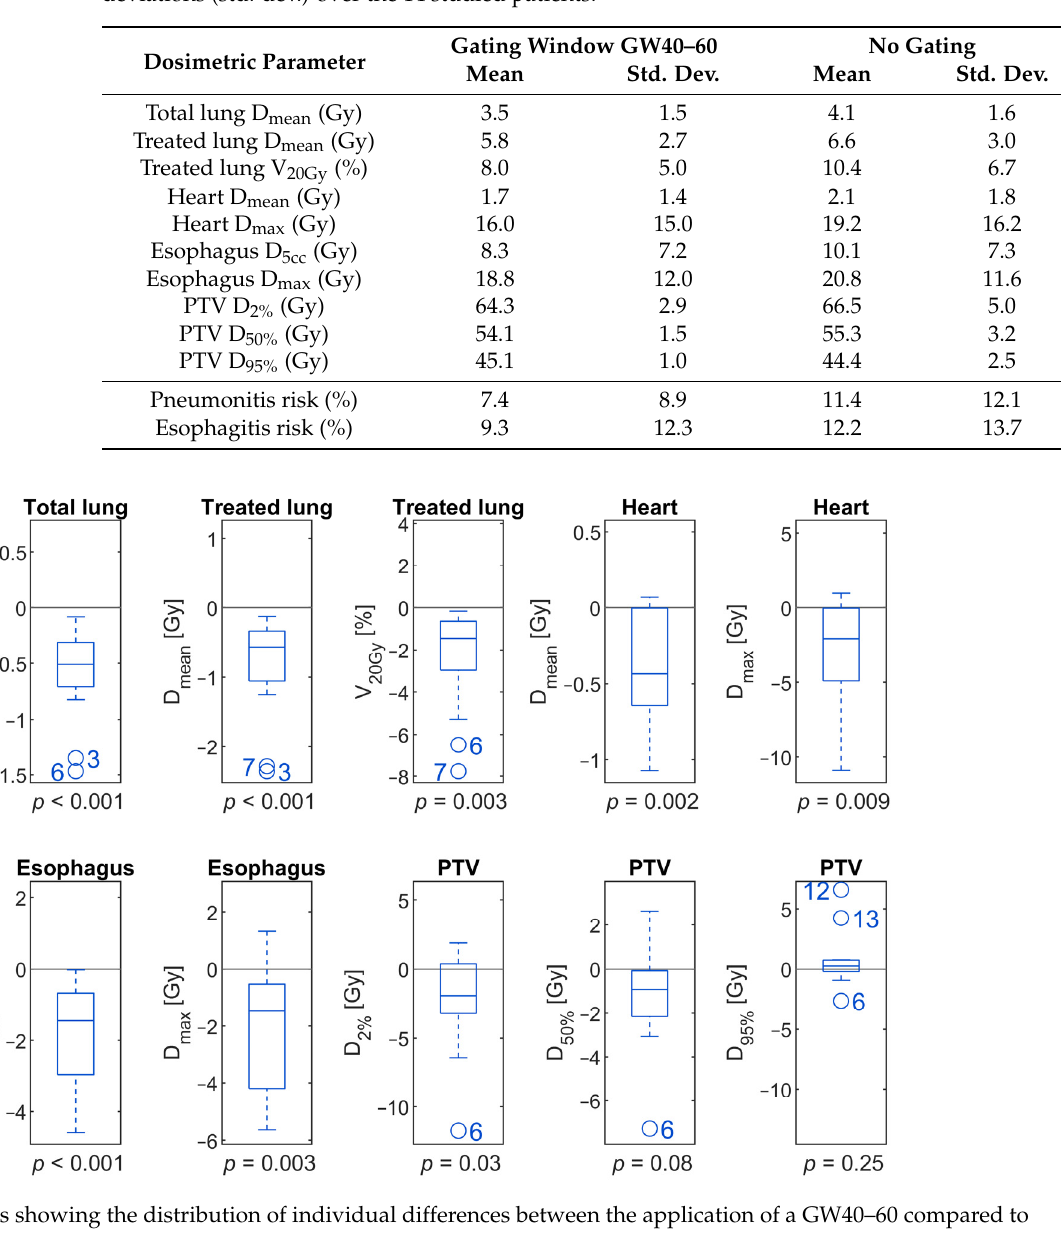
Table 2. Differences in dosimetric parameters and in the risks of pneumonitis and esophagitis between gating window GW40–60 and no gating. Reported are the mean values and standard deviations (std. dev.) over the 14 studied patients.